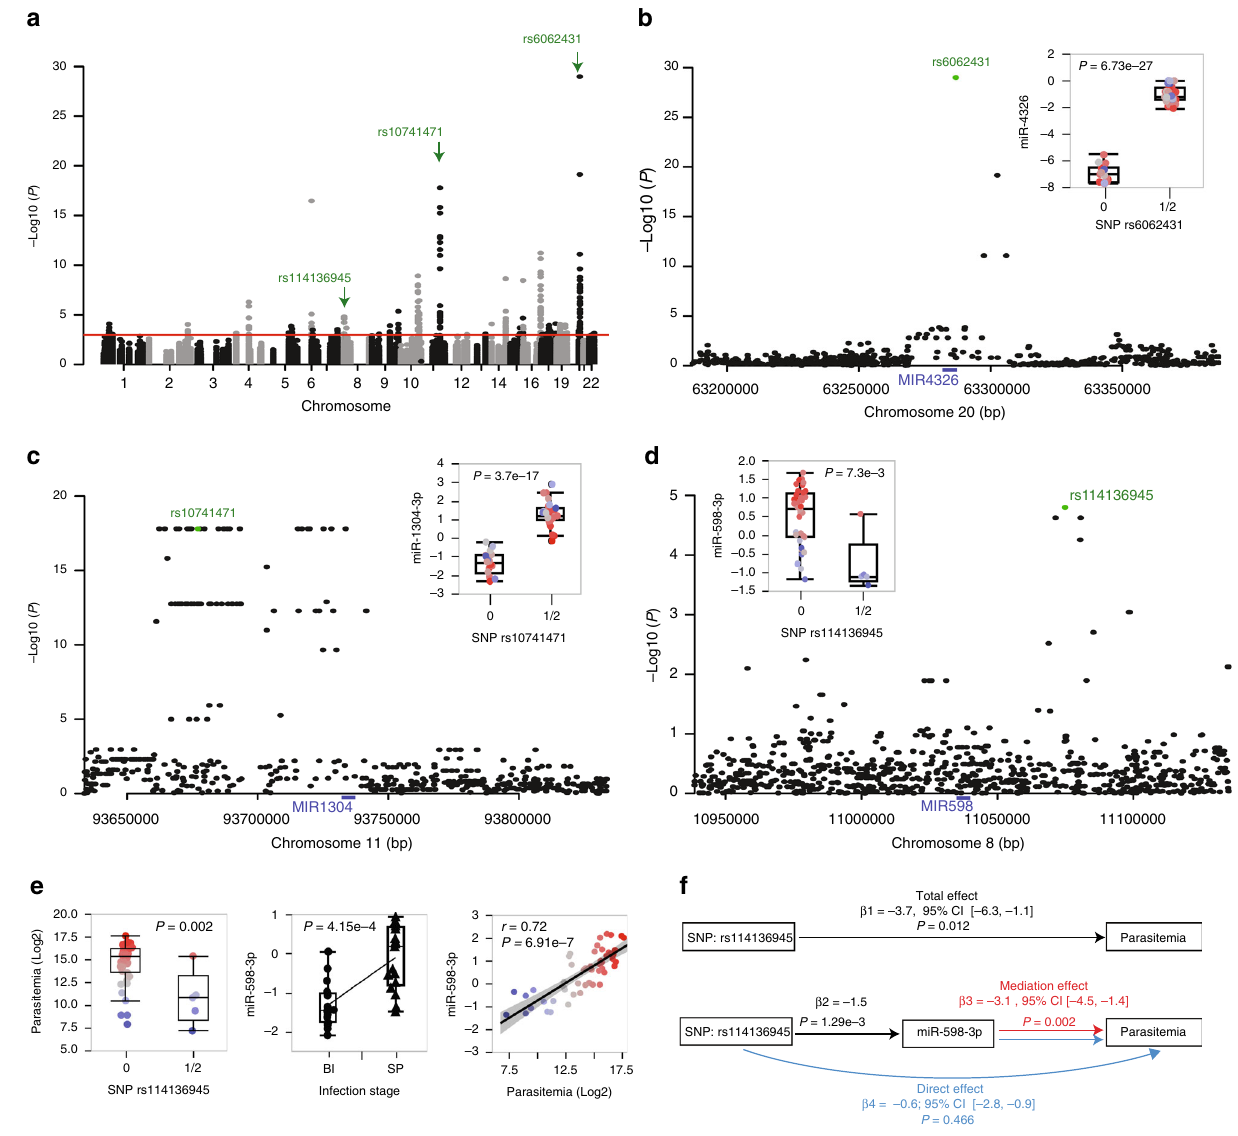
Fig. 3 Genetic control of miRNA expression in malaria. a Manhattan plot of all associations tested between 276 miRNAs and 129,310 cis -SNPs. Associations implicating miR-4326, miR-1304-3p, and miR-598-3p are shown in green and in b – d , respectively. The associations shown are for SNPs spanning a 200-kb window centered on the miRNA in question. Peak SNPs are shown in green. The boxplots in b – d show miRNA expression and associated SNP data with host genotype (0, reference allele homozygote individuals versus 1/2, heterozygotes and alternative allele homozygote individuals (miR-4326/SNP rs6062431, miR-1304-3p/SNP rs10741471, and miR-598-3p/SNP rs114136945, n = 46). B – H FDR P values (linear regression model in PLINK v1.9) for each association are shown. e Association between parasitemia and SNP rs114136945 (left graph, nominal P value = 0.002, two- tailed student ’ s t test), miR-598-3p expression in the BI ( n = 19) and SP ( n = 17) groups (middle graph, B – H P = 4.15e-4, repeated measure ANCOVA), and right, correlation between miR-598-3p expression and log2 parasitemia in the replication set ( n = 53, Pearson correlation coef fi cient r = 0.72, and P = 6.9e-7, multiple regression adjusting for sex, age, and white blood cell count). Each individual is colored by its log2 parasitemia (from the lowest (blue) to the highest (red). The box plots in b – e show the median, the 25th and 75th percentiles as box edges, and the 5th and 95th percentiles as bounds of whiskers. f Mediation analysis to evaluate potential causal relationship between SNP rs114136945 and log2 parasitemia through modulation of miR-598-3p expression. The regression coef fi cients β , their 95% con fi dence intervals and P values for each test are shown: β 1 ( − 3.7), [ − 6.3, − 1.1], P = 0.012, β 2 ( − 1.5), P = 1.29e-3 β − 3.1), [ − 4.5, − 1.4], P = 0.002 and β − 0.6), [ − 2.8, − 0.9], P = , 3, ( 4 (